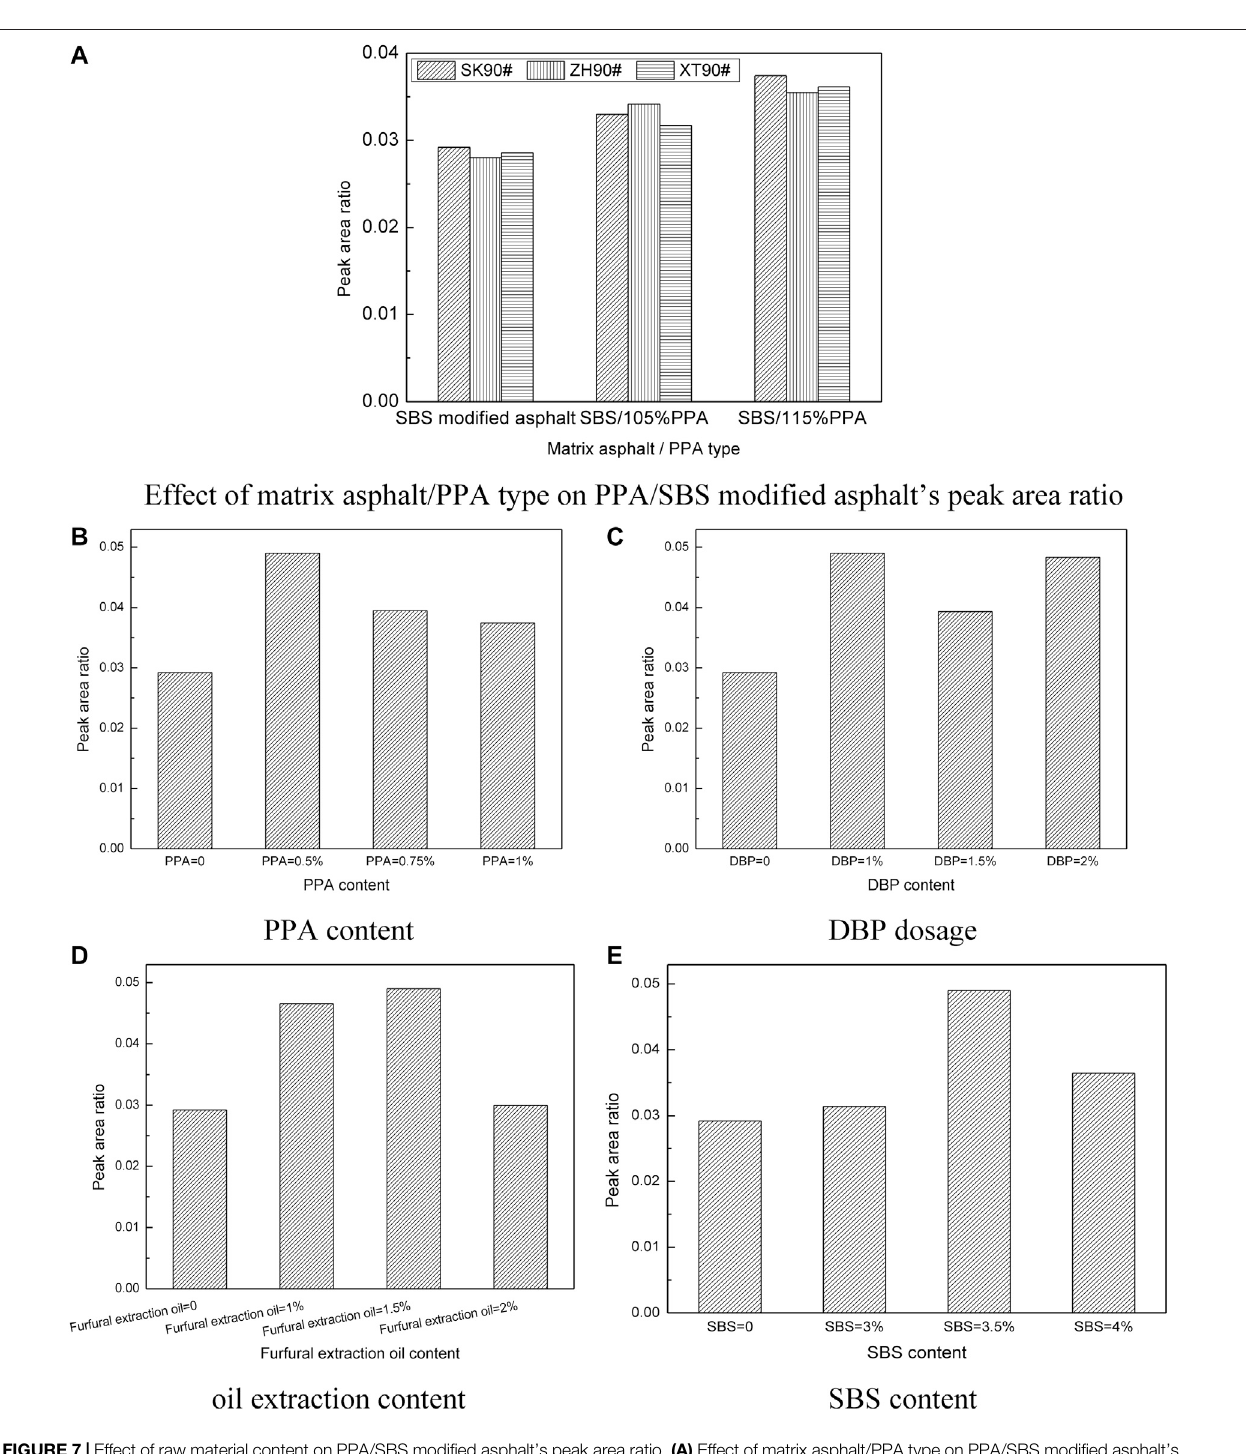
FIGURE 7 | Effect of raw material content on PPA/SBS modi fi ed asphalt ’ s peak area ratio. (A) Effect of matrix asphalt/PPA type on PPA/SBS modi fi ed asphalt ’ s peak area ratio. (B) PPA content. (C) DBP dosage. (D) oil extraction content. (E) SBS content.